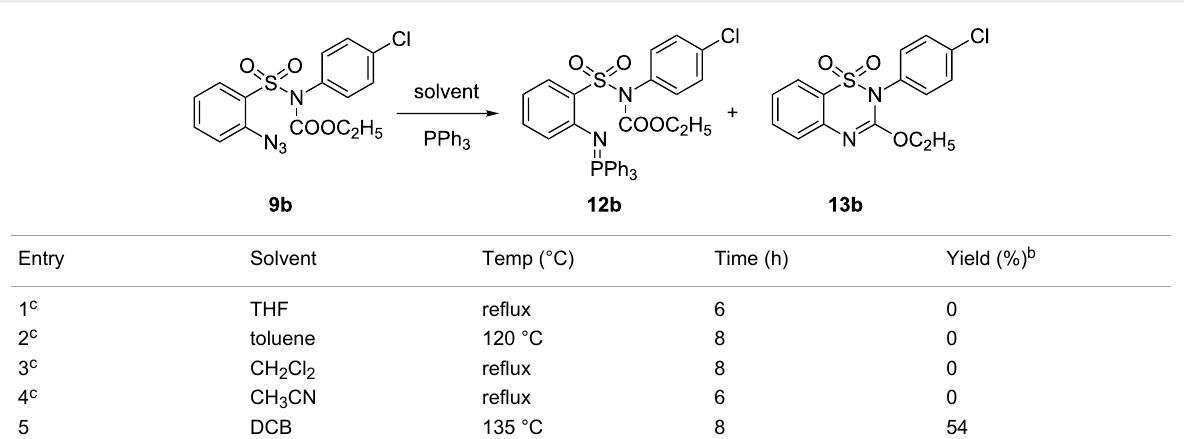
Table 1: Summary of the intramolecular aza-Wittig reactions .